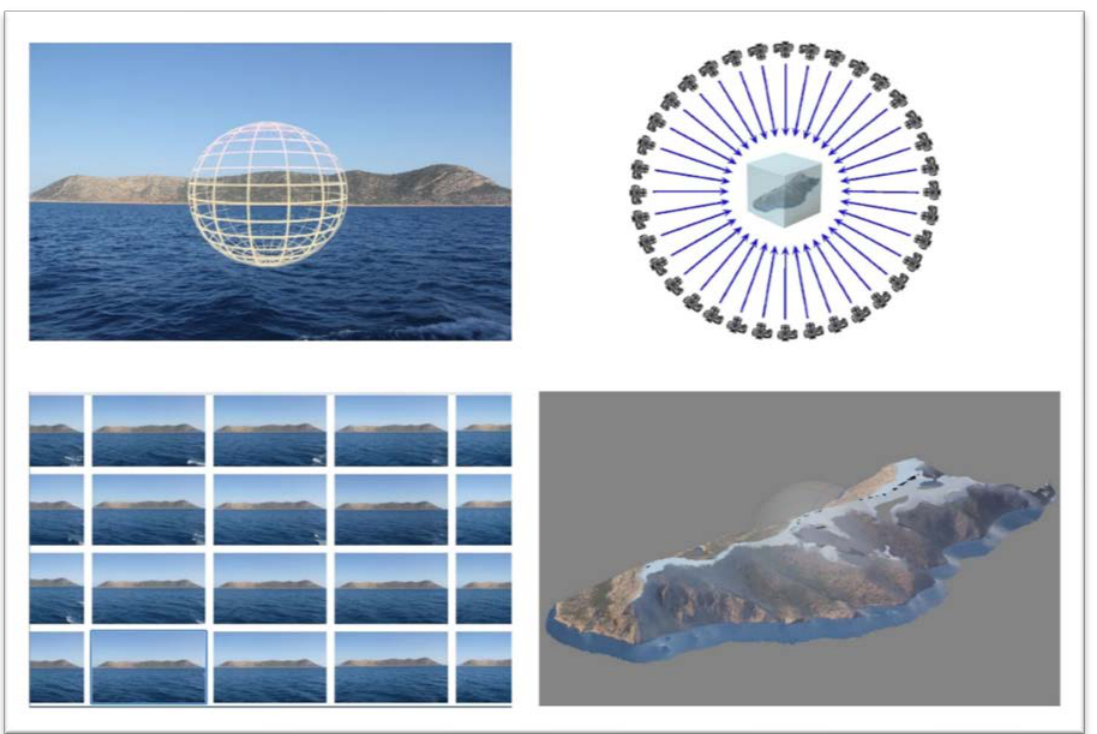
Figure 9 . 3D modelling of Dana Island by using